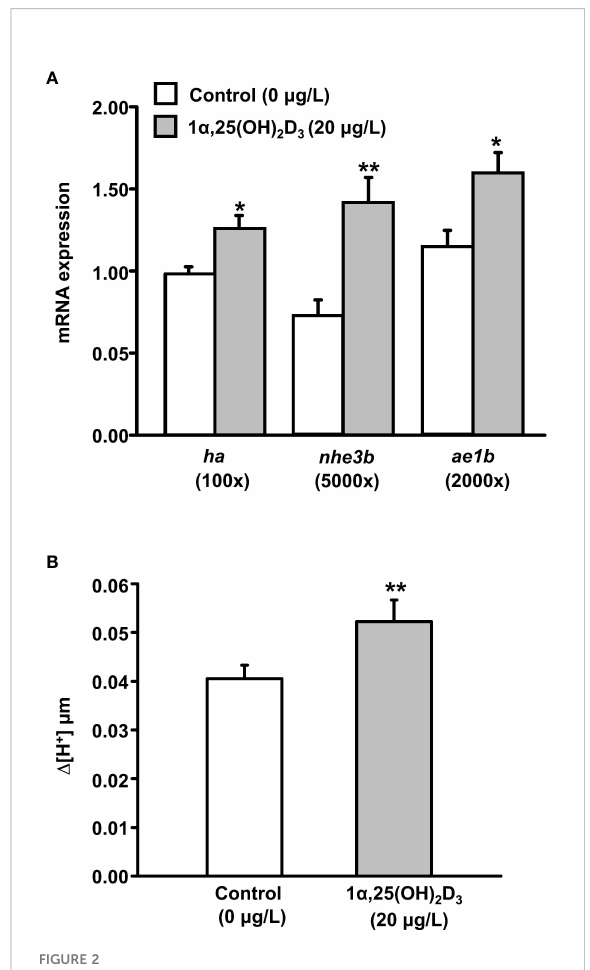
FIGURE 2 Effects of exogenous 1 a ,25(OH) 2 D 3 treatment on (A) the mRNA expression of transporter genes and (B) proton secretion in the skin surface of 3 dpf zebra fi sh larvae. The mRNA expressions were analyzed by qPCR, and the values were normalized to b - actin. Scanning ion-selective electrode technique (SIET) was used to measure the H + activity on the skin. Values were expressed as the mean ± SEM ( n = 6 – 12). Student ’ s t-test, * p < 0.05; ** p <